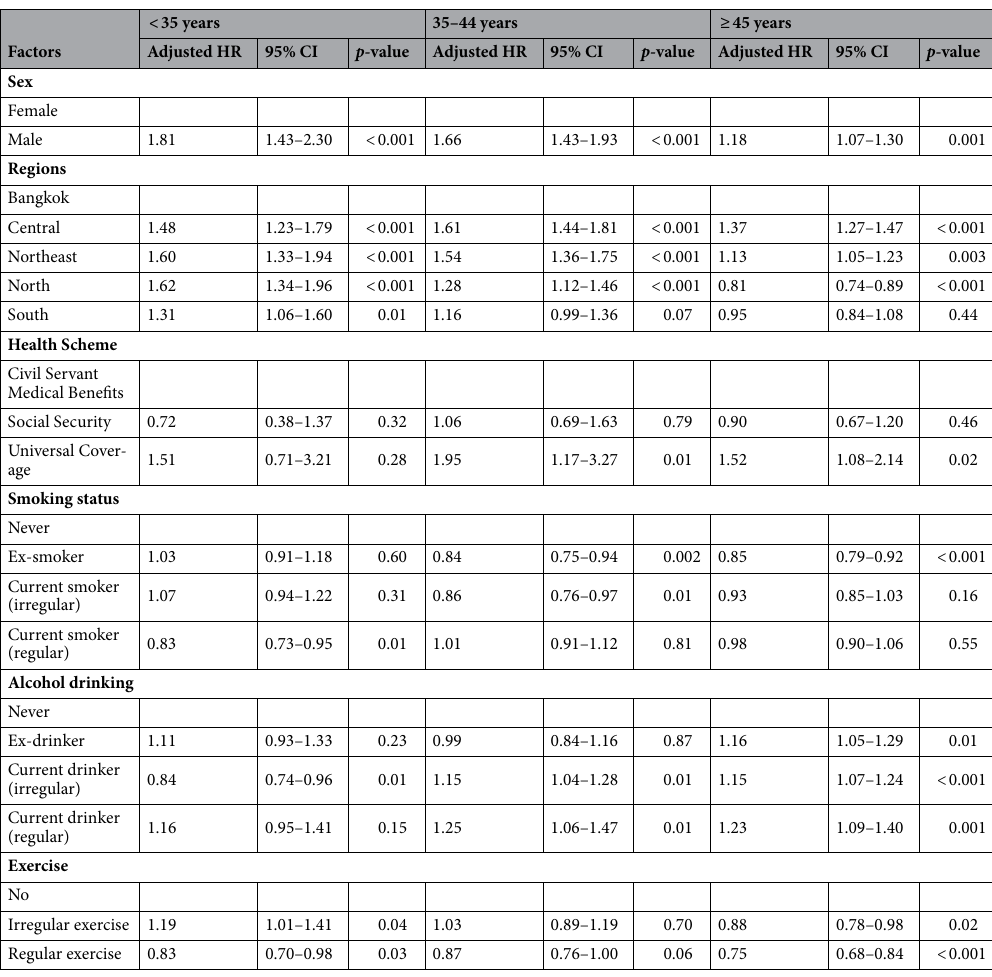
Table 5. Multivariable analysis of the association between demographic, behavioral, and clinical factors and the incidence of metabolic syndrome among RTA personnel, stratified by age. HR Hazard ratio, 95% CI 95% confidence